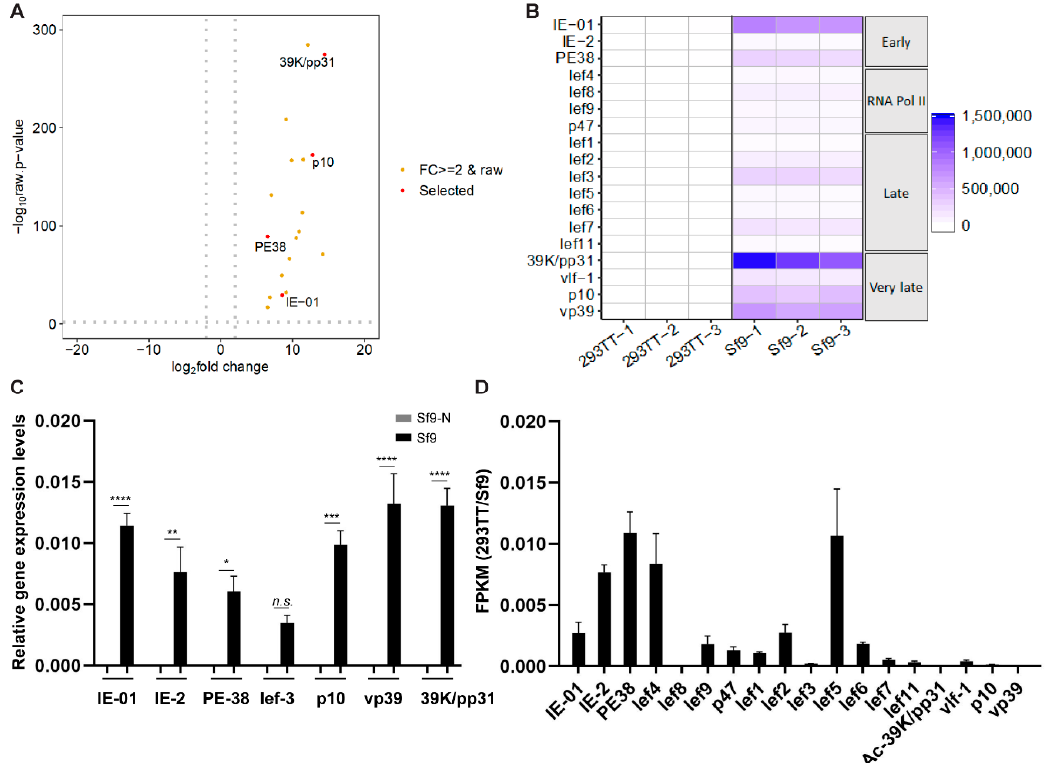
Figure 4. Transcriptome profiles of baculovirus early- and late-expressed genes in human cells. ( A ) Volcano plot shows the fold change (log 2 transformed) and variance for baculovirus early- and late-expressed genes in AcHERV env -CMV-GFP-infected 293TT cells relative to virus-infected Sf9 cells. ( B ) Heatmap showing the relative changes in expression of representative early and late-expressed baculovirus genes. ( C ) qRT-PCR analysis of baculovirus early and late genes in Sf9 cells, confirming the RNA-seq data. Results are shown as the means ± s.e.m. of six independent replicates. * p < 0.05, ** p < 0.001, *** p < 0.0001, **** p < 0.00001. n.s. , not significant. ( D ) Bar graph showing relative levels of expression of 18 representative baculovirus genes in 293TT cells. FPKM values of baculovirus gene transcript in 293TT cells were normalized to those of Sf9 cells.